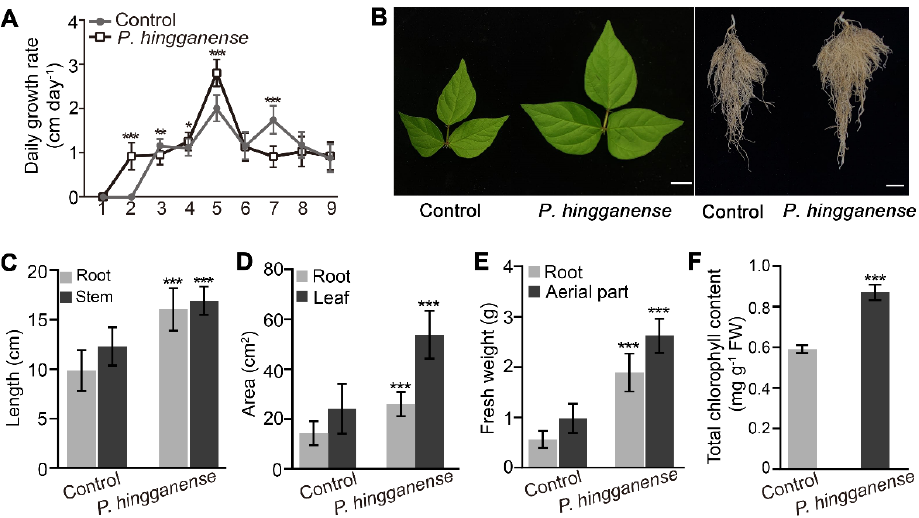
Figure 2. Growth promotion of P. hingganense on mung bean plants. ( A ) Comparison of the daily growth rate of P. hingganense − treated and non − treated plants within 9 days of planting in soil. Val- ues are means ± SD (n = 20). ( B – F ) Phenotypes of P. hingganense − treated plants. ( B ) Growth of 21 − day − old mung bean plants. Bars, 2 cm. ( C ) Lengths of the root and stem; ( D ) root and leaf area. ( E ) Fresh weight. ( F ) Total chlorophyll content. Values are means ± SD (n = 25). Asterisks indicate significant differences as evaluated by Student’s t -tests: * p < 0.05, ** p < 0.01, *** p < 0.001.